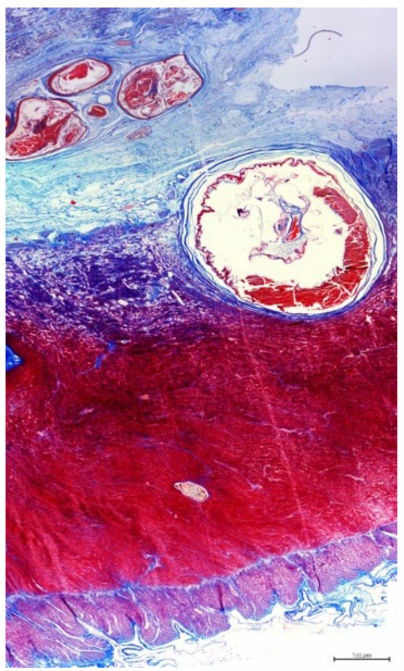
Figure 7. Histology, MT stain. Stomach, submucosa and muscularis adjacent to the cysts effaced and replaced by extensive areas of fibrous connective tissue (scale bar = 500 µ